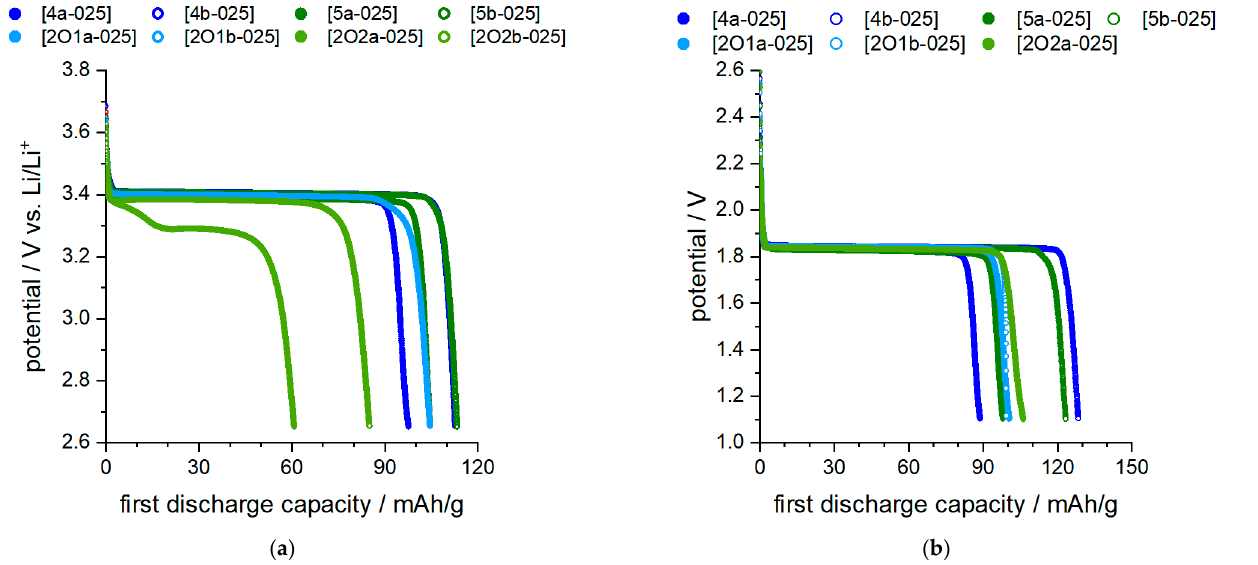
Figure 9. Cycle test in battery cells. ( a ): half cell, Li vs. LFP; ( b ): full cell, LTO vs.